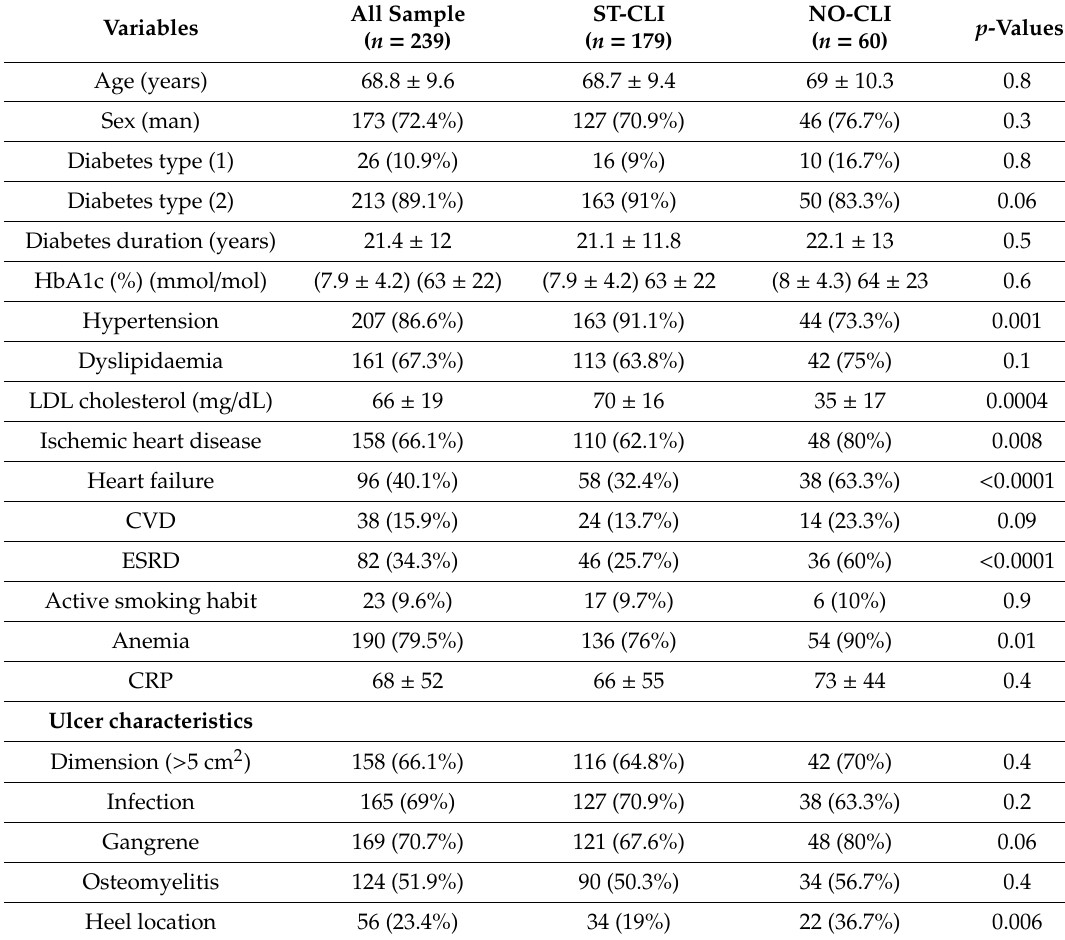
Table 1. Demographic, clinical, and ulcer characteristics of all samples, successfully treated critical limb ischemia (CLI) patients (ST-CLI), and no-option CLI patients (NO-CLI). LDL: low-density-lipoprotein; CVD: cerebrovascular disease; ESRD: end-stage renal disease; CRP: c-reactive protein. A p -value < 0.5 was considered statistically